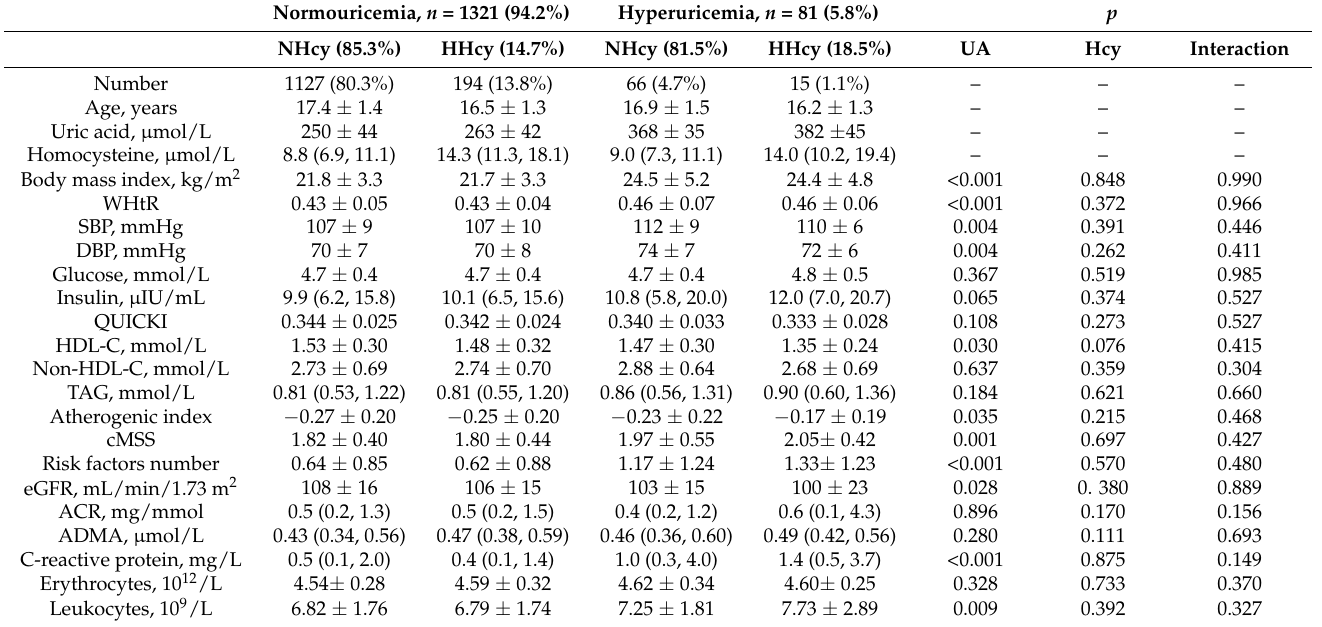
Table 5. Characteristics of females according to uricemia and homocysteinemia.